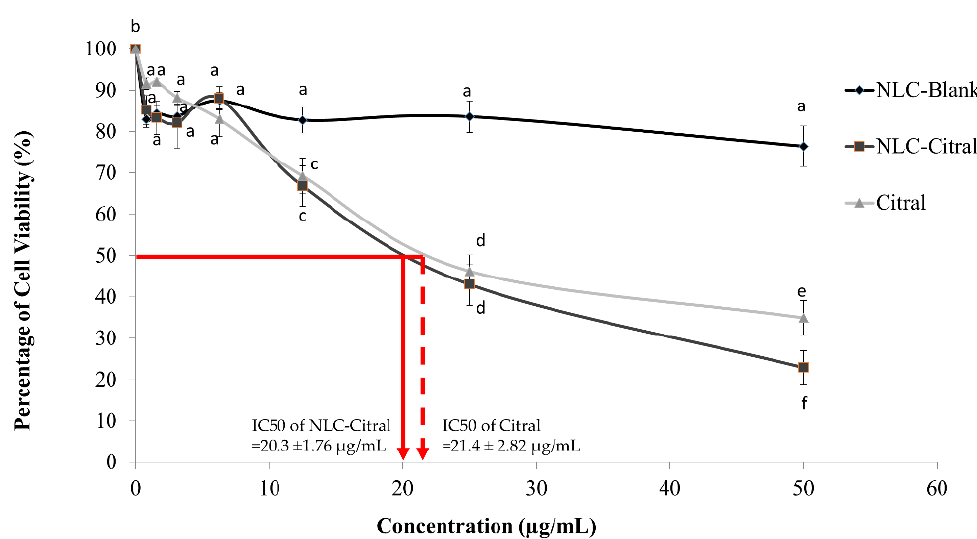
Figure 1. The percentage of viable 4T1 cells treated with di ff erent concentrations of NLC-Blank, NLC-Citral, and citral at 48 h in MTT assay. Each value is represented as mean ± SD and the experiment was done in triplicate. The red line indicates how the IC 50 for NLC-Citral (full red line) and Citral (dotted red line) was obtained. Significance indicated by di ff erent alphabet was set at p < 0.05 comparing between groups.